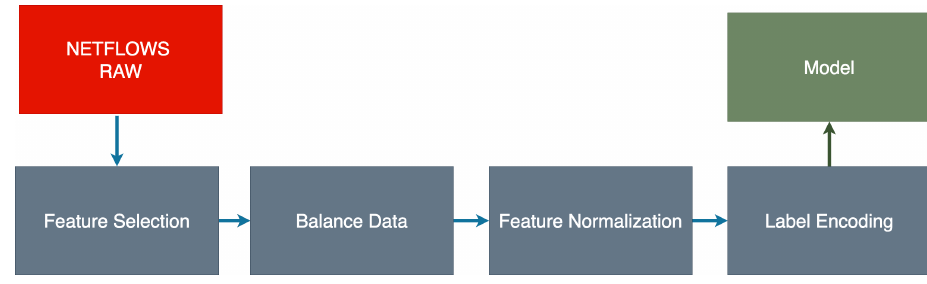
Figure 3. Process of preparing the collected